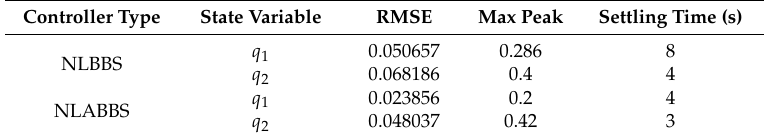
Table 4. Report of the dynamic performances of the adaptive and conventional block-backstepping controllers.